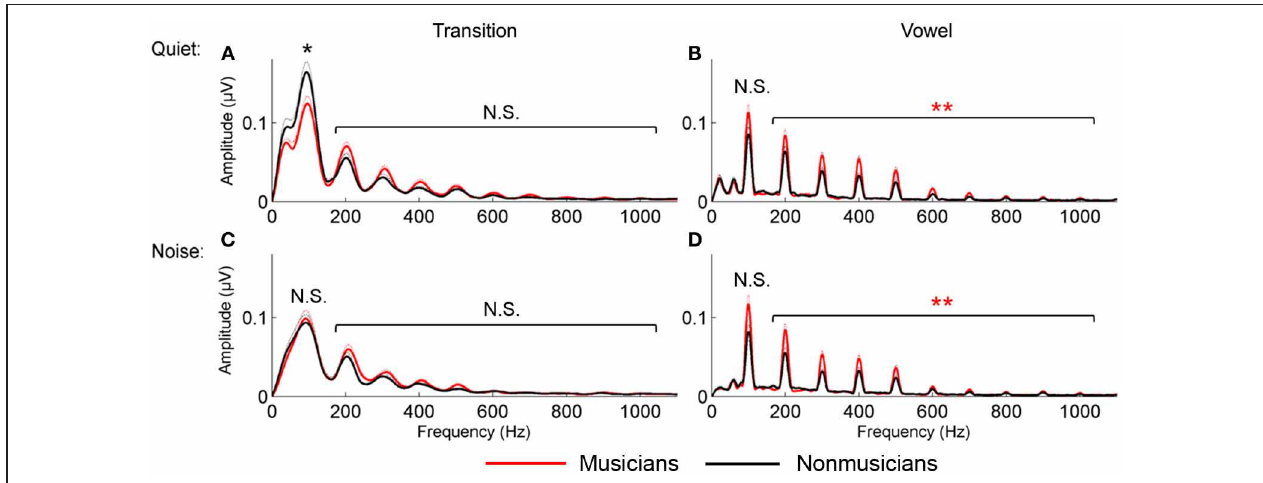
FIGURE 3 | Spectral encoding for the transition (A and C) and vowel (B and D) in quiet (A and B) and noise (C and D). Musicians (red) demonstrated enhanced spectral encoding forthevowelinbothquietandnoise;nonmusicians (black)hadgreater F 0 encoding inthetransition inquietonly. ∗ p < 0 . 05, ∗∗ p < 0 . 01.